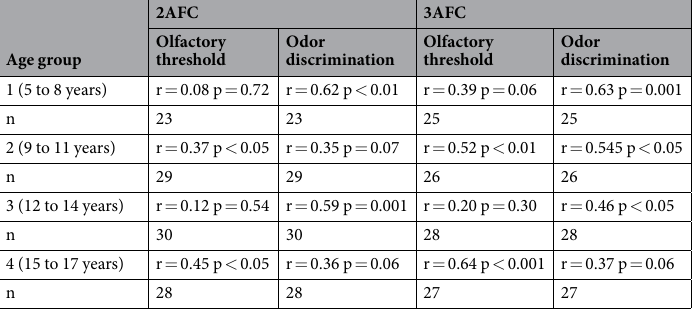
Table 2. Correlation coefficients and significance of age groups between first and second testing (n: number of subjects, r: correlation coefficient, p: level of significance). Olfactory threshold scores in phenyl ethyl alcohol dilution steps; odor discrimination scores in number correctly performed